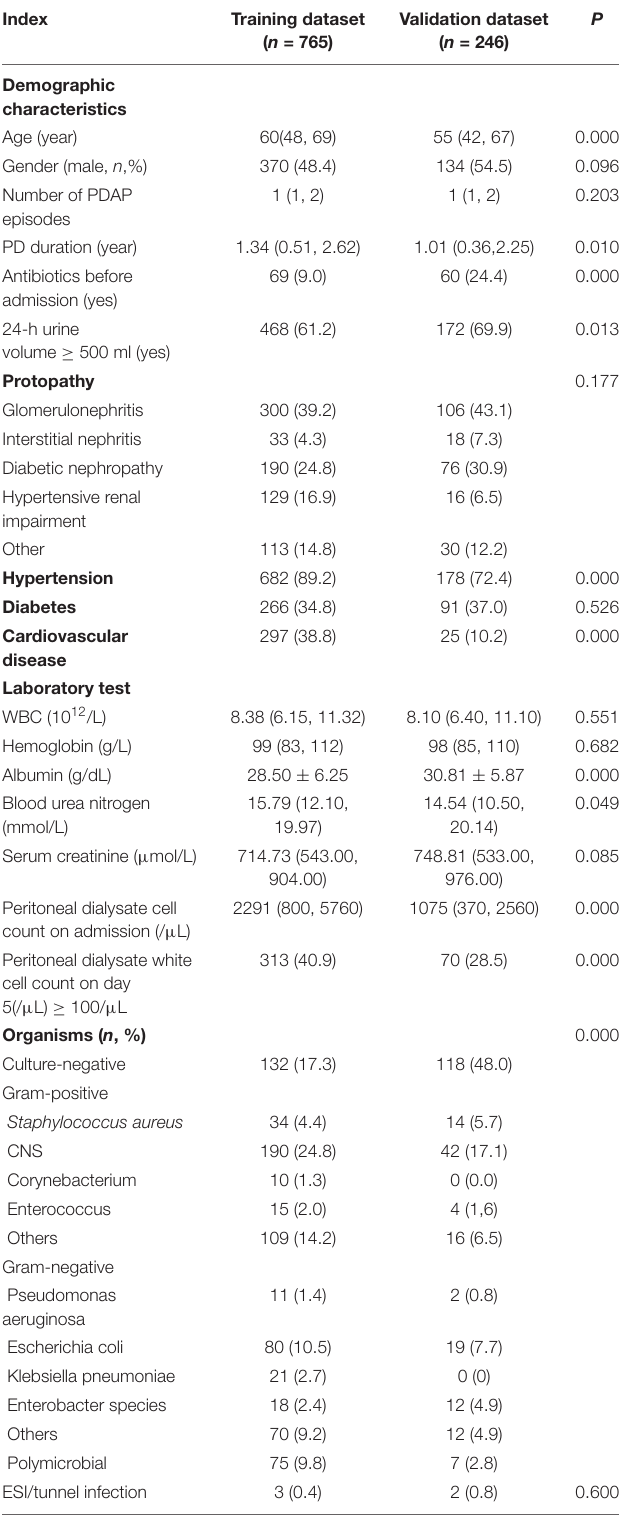
TABLE 1 | Baseline demographic and laboratory parameters of 1011 PDAP episodes in the training and validation